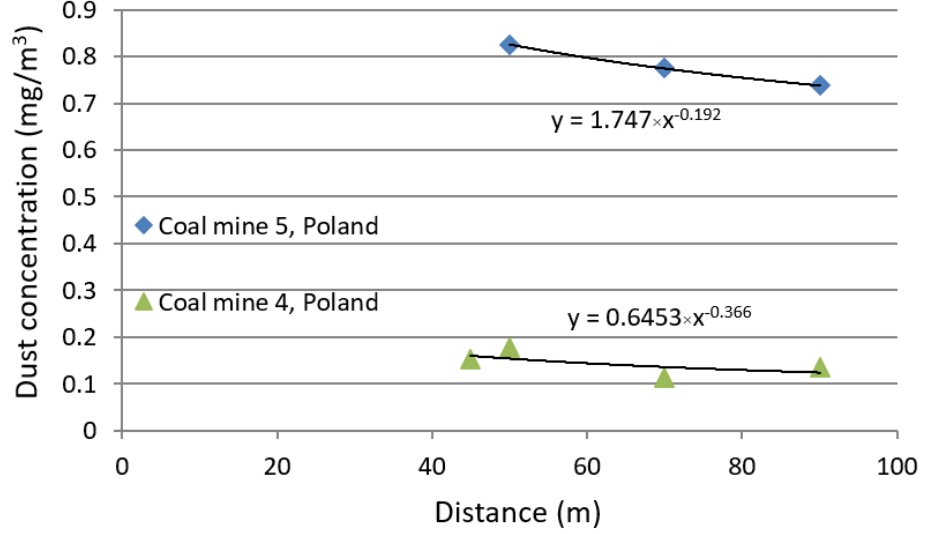
Figure 11. Characteristics of the distribution of PM2.5 dust concentration depending on the distance from a dust source, measured with the IPSQ analyzer in coal faces, together with the functions that describe them.